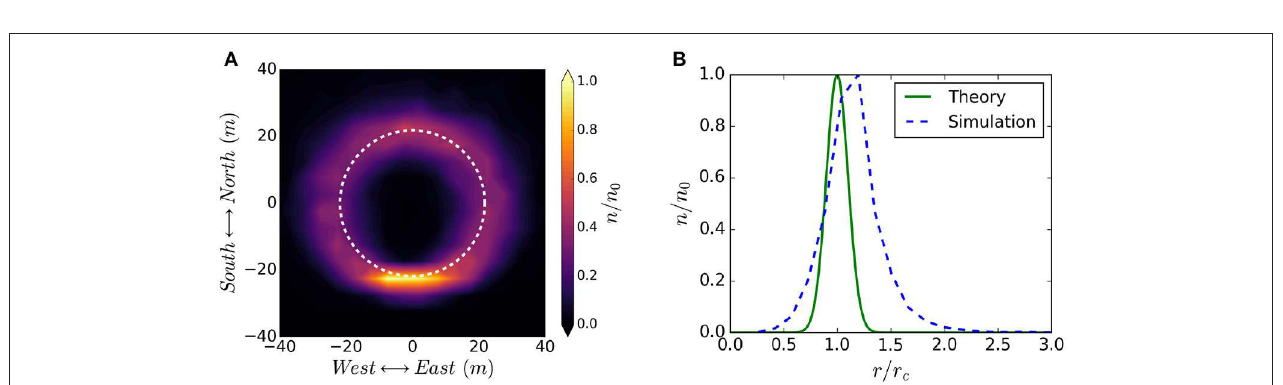
FIGURE 12 | Displacement of the center of the beam spot and Earth rotation. The white dashed line indicates the radius corresponding to Geostationary Orbit (GEO).